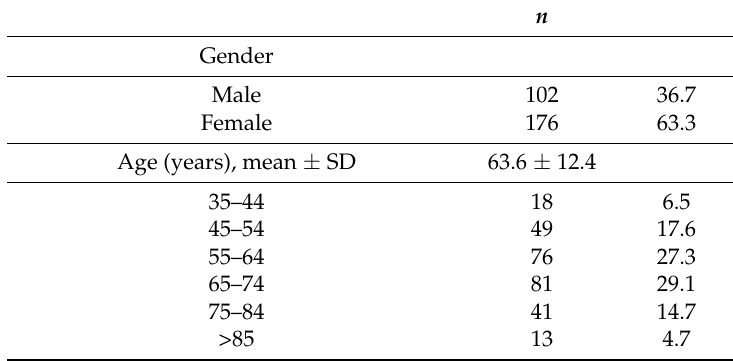
Table 1. Baseline sociodemographic and clinical characteristics of study participants [ n =